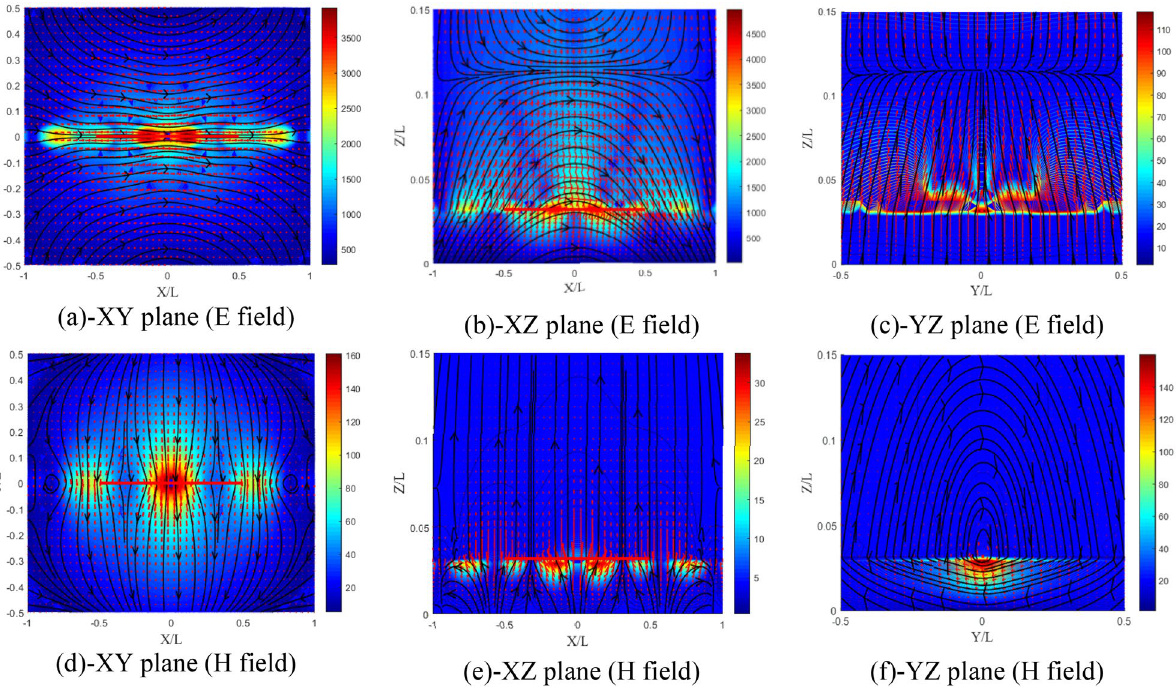
Figure 18. Distribution of the electromagnetic field components of the isotropic substrate ( a–c ) electric and ( d – f ) magnetic field components.